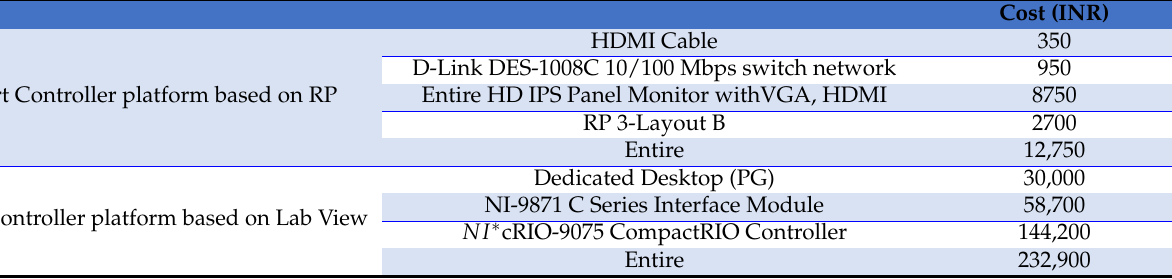
Table 1. Costs comparing among IoT based RP enabled intelligent controller and LabVIEW enabled intelligent